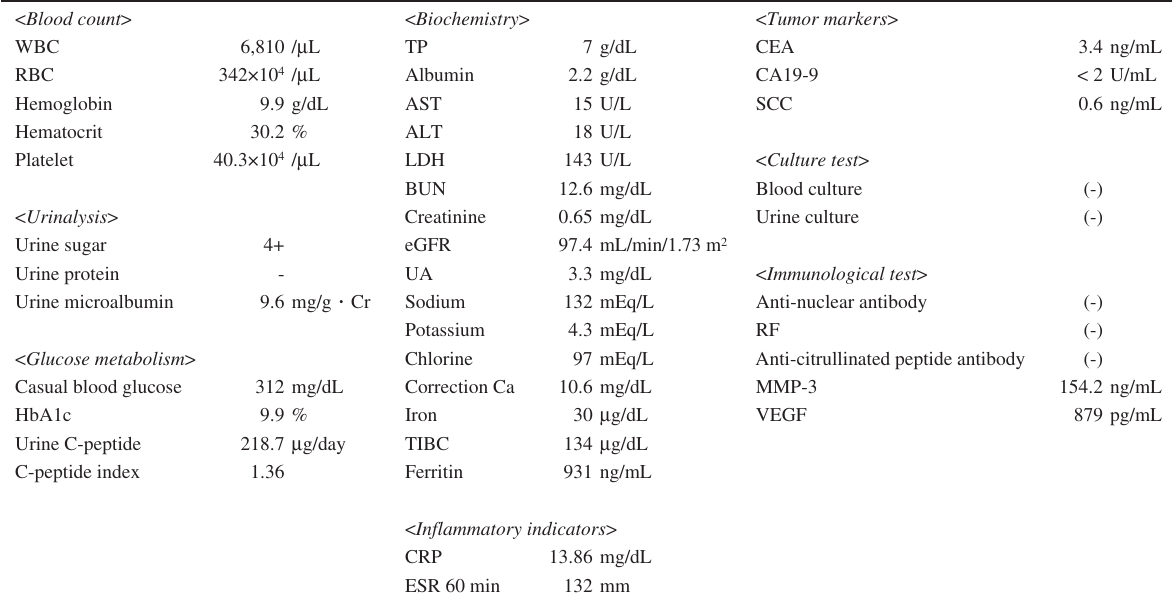
Table 1. Laboratory data on